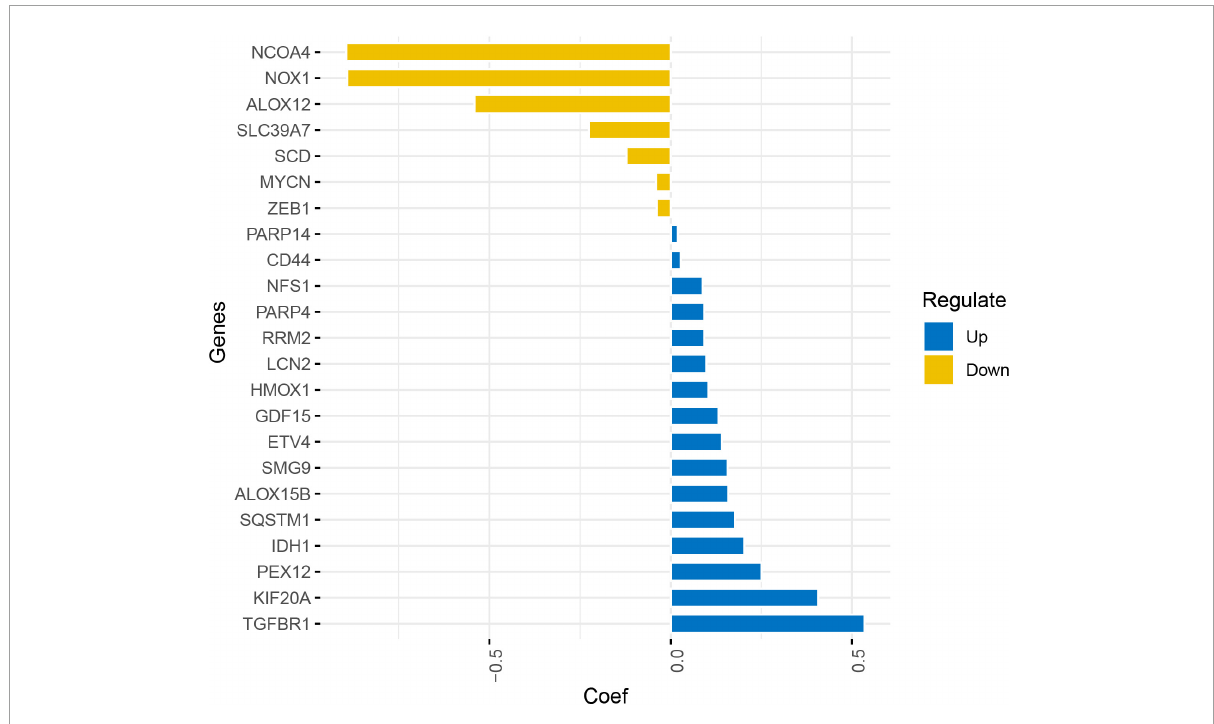
FIGURE5 Least absolute shrinkage and selection operator coefficient profile of the candidate genes.